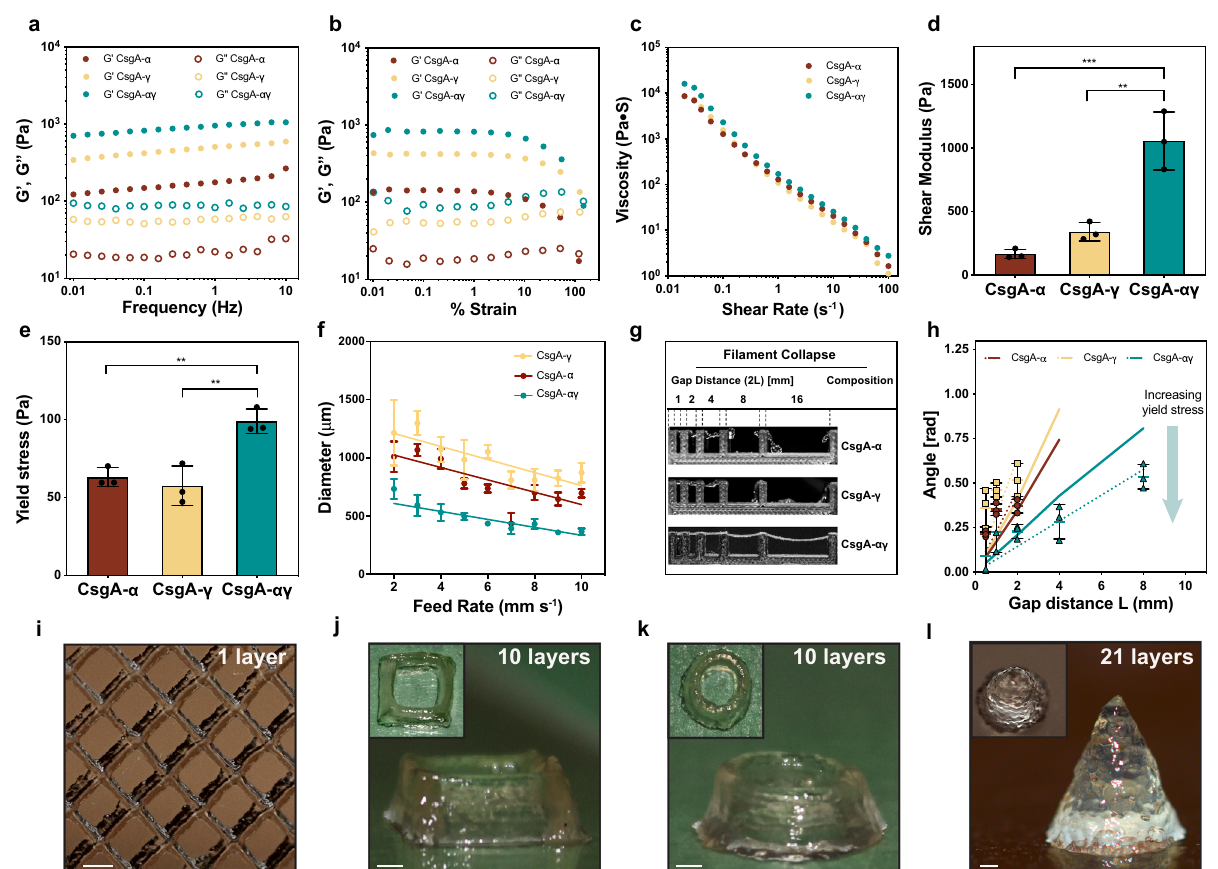
Fig. 3 Rheological properties and 3D printing of CsgA- α , CsgA- γ and microbial ink CsgA- αγ . The storage modulus (G ’ ) and loss modulus (G ” ) under frequency sweep ( a ) and oscillatory sweep ( b ). c Viscosity as a function of shear rate, d Shear modulus ( n = 3) ** p = 0.0014, *** p = 0.0004 and e yield stress ( n = 3) ** p = 0.0061, ** p = 0.003, one-way ANOVA followed by Dunnett ’ s test. f Printed line diameter as a function of feed rates ranging from 2 to 10 mm s − 1 at 20 psi pressure ( n > 10). g Images of fi lament collapse test and h . the plot of de fl ection angle versus pillar gap distances ( n = 3). Experimental data: solid line, theoretically predicted data: dotted line. Data represented as mean ± standard deviation. ** p ≤ 0.01, *** p ≤ 0.001, one-way ANOVA followed by Dunnett ’ s test. 3D printed structures using the microbial ink CsgA- αγ i single-layer grid, j 10-layer square, k 10-layer circle, and l 21-layer solid cone. Insets in ( j – l ). are corresponding top views. Scale bar 1